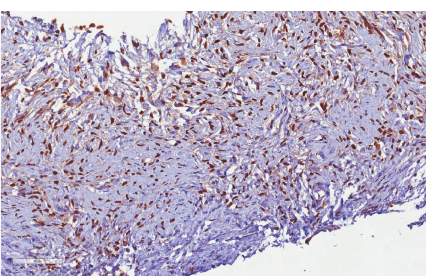
Figure 5: Diffuse nuclear expression of